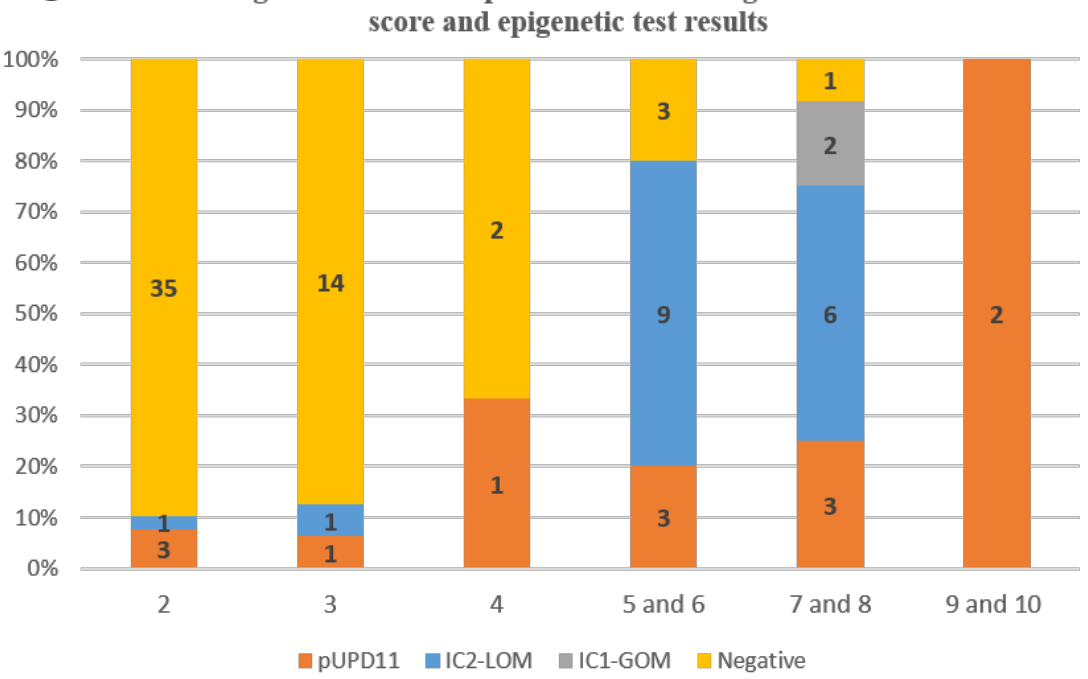
Figure 2. Epigenetic alterations in all patients with lateral overgrowth ( A ) and isolated lateralized overgrowth ( B ). The distribution of epigenetic alterations according to clinical scoring in LO patients ( C ).